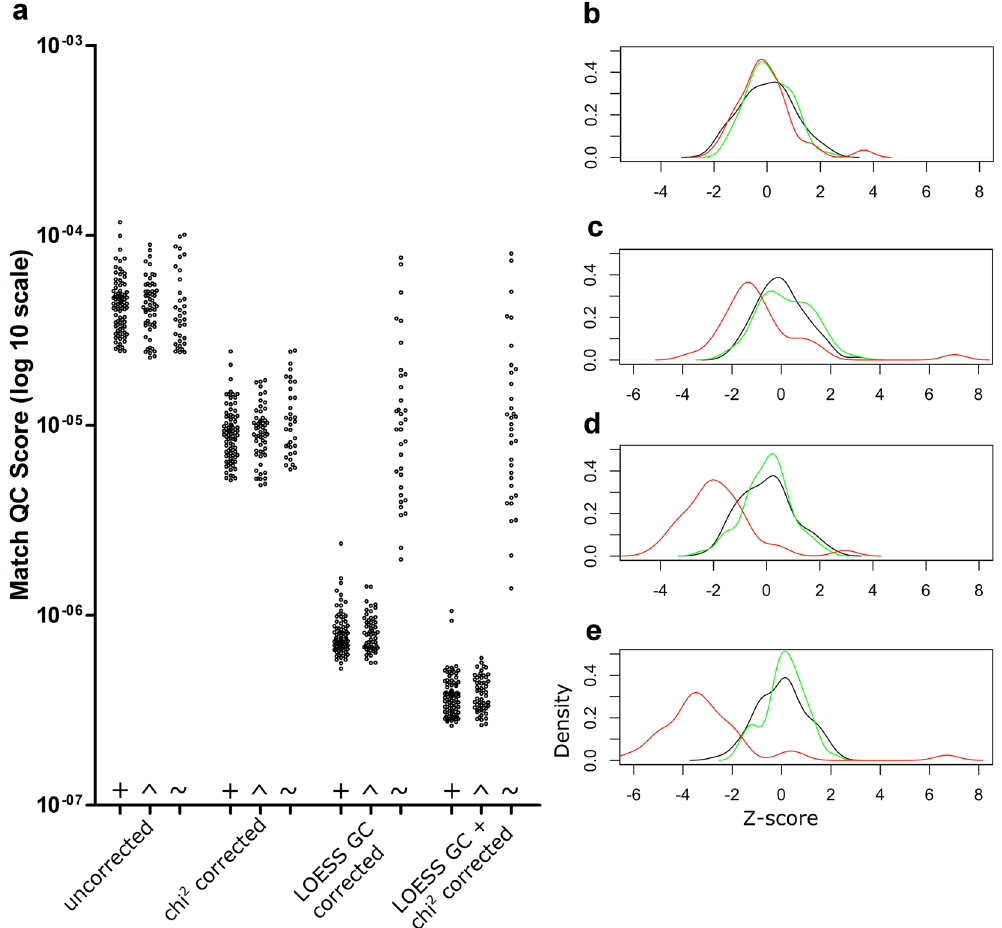
Figure 7. Match QC scores and Z-scores for matching and non-matching samples. ( a ) Match QC scores per sample for uncorrected, chi-squared corrected, LOESS GC corrected and both LOESS GC and chi-squared corrected data for the control group, matching samples, and non-matching samples. Chromosome 21 Z-scores for ( b ) uncorrected data, ( c ) chi-squared corrected data, ( d ) LOESS GC corrected data and ( e ) both LOESS GC and chi-squared corrected data. + and black line, control group samples; ^ and green line, samples that underwent the same sample preparation procedure; ~ and red line, single centrifugation plasma